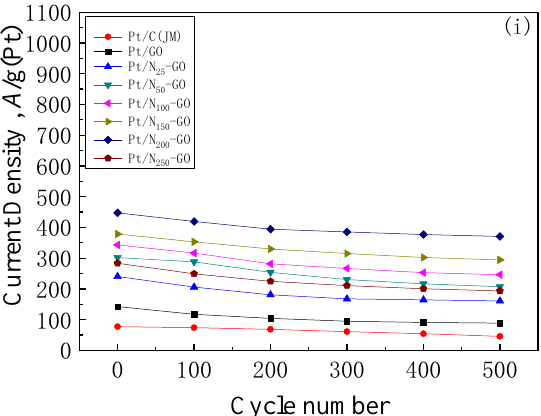
Figure 10. Cyclic voltammograms recorded during depletion of the catalysts: ( a ) Pt/C(JM), ( b ) Pt/GO, ( c ) Pt/N 25 -GO, ( d ) Pt/N 50 -GO, ( e ) Pt/N 100 -GO, ( f ) Pt/N 150 -GO, ( g ) Pt/N 200 -GO, ( h ) Pt/N 250 -GO; ( i ) changes in the peak current density during ethanol oxidation as a function of the number of cycles.